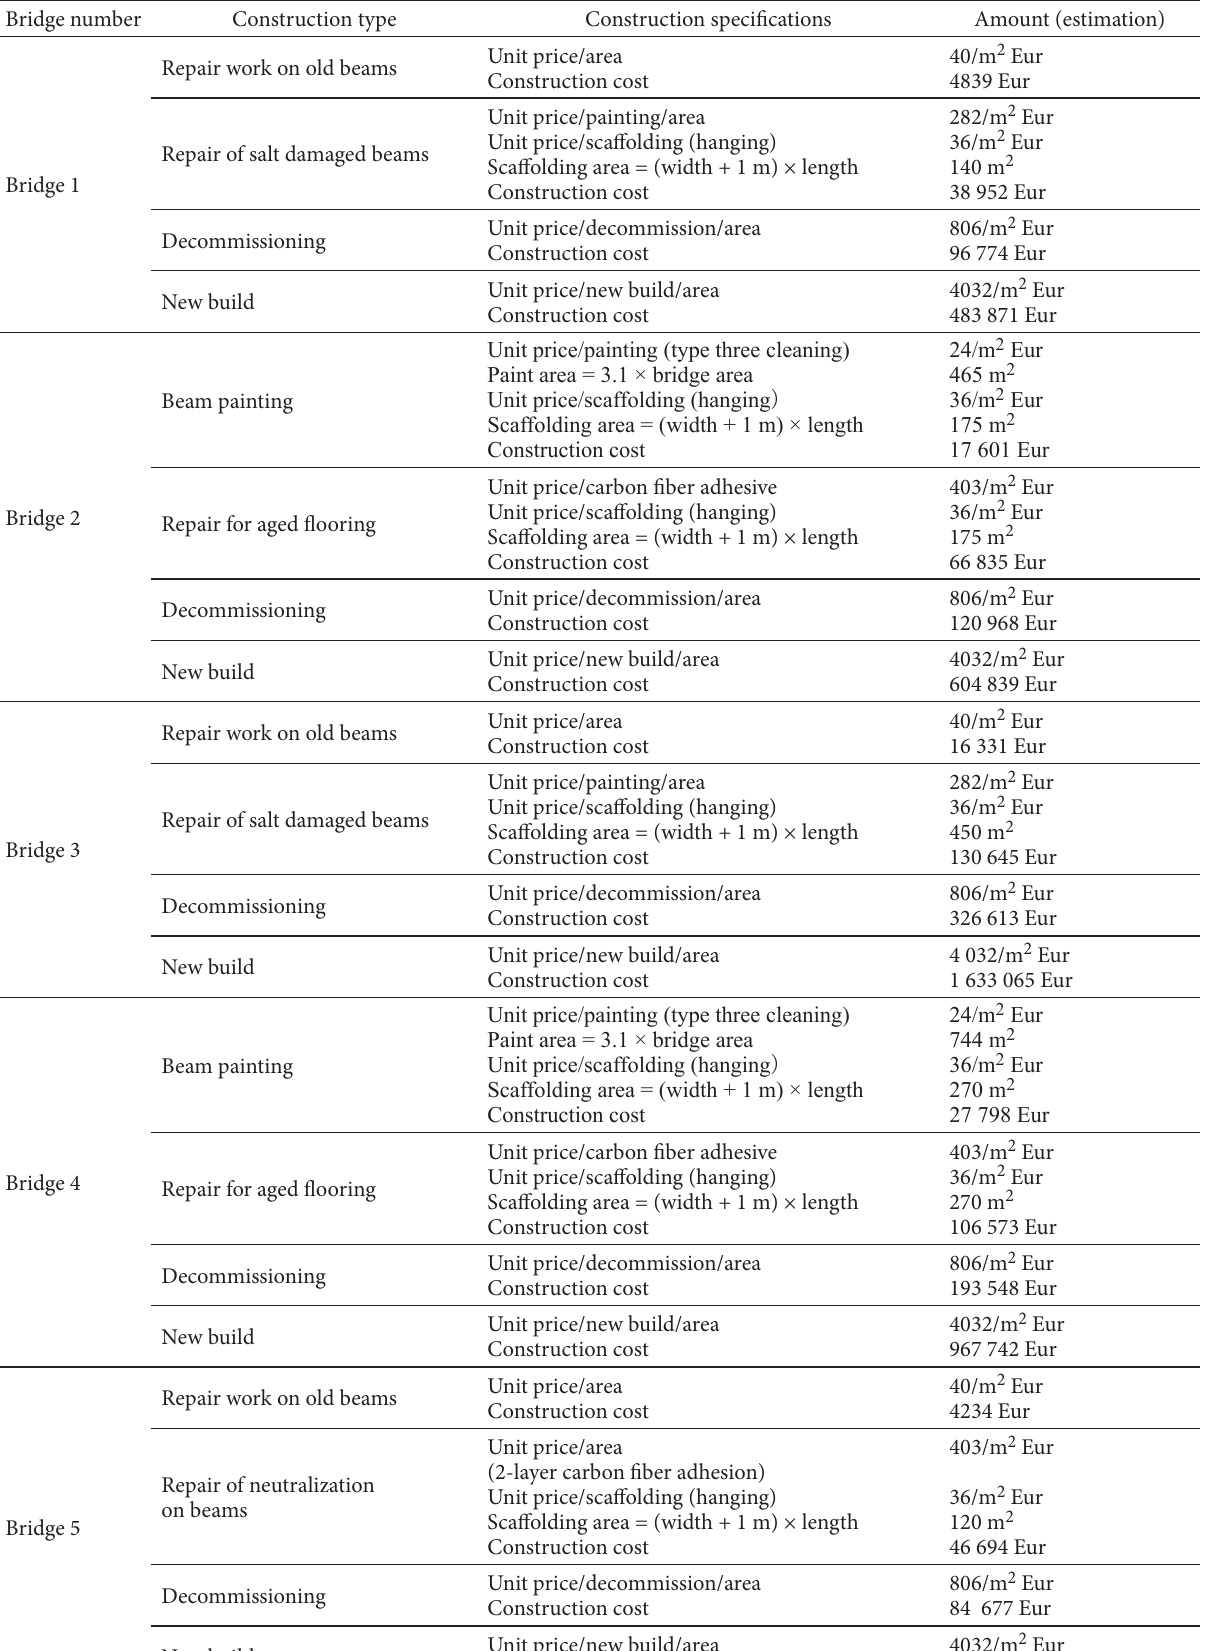
Table 3. Tentative construction cost of bridge (example: Bridges 1–5) Bridge